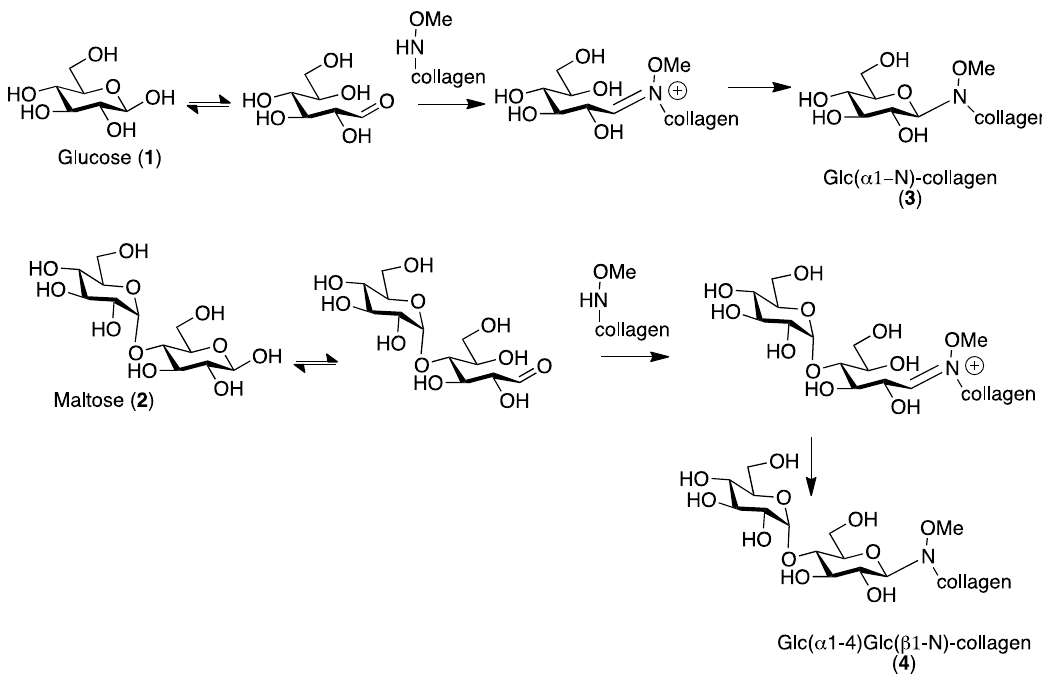
Scheme 1. N -methoxamino- chemoselective